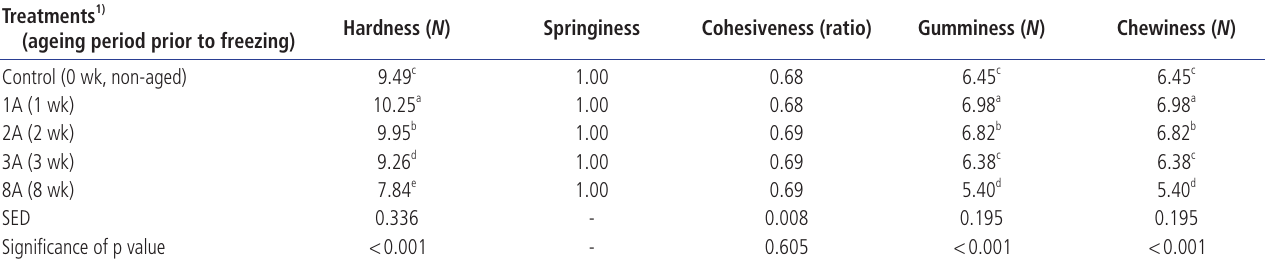
Table 4. Textural properties of model sausages formulated with aged/frozen/thawed lamb loins Treatments